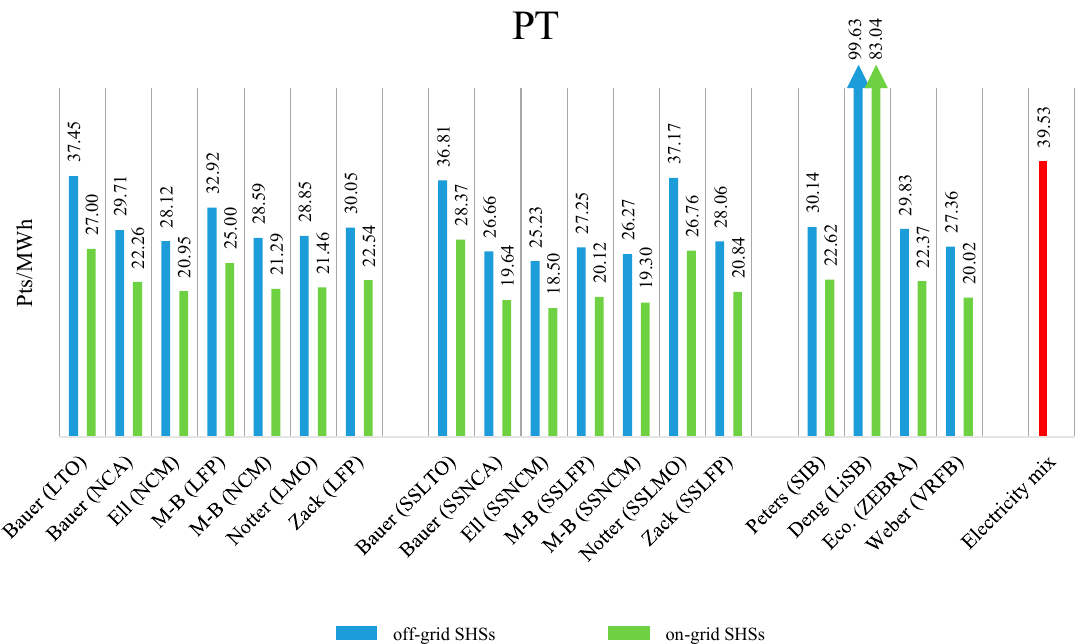
Figure 11. LCA impact values of SHSs in Portugal as single scores.